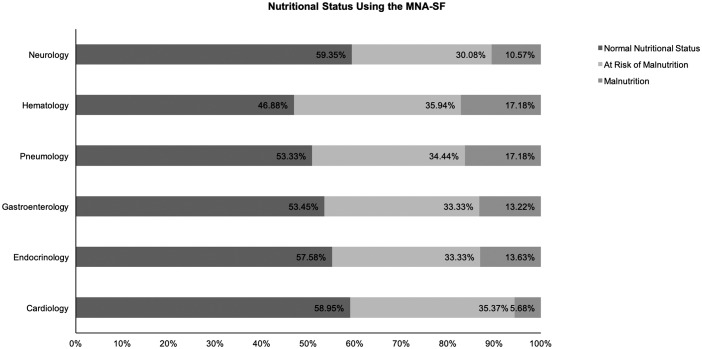
Nutritional status using the MNA-SF.